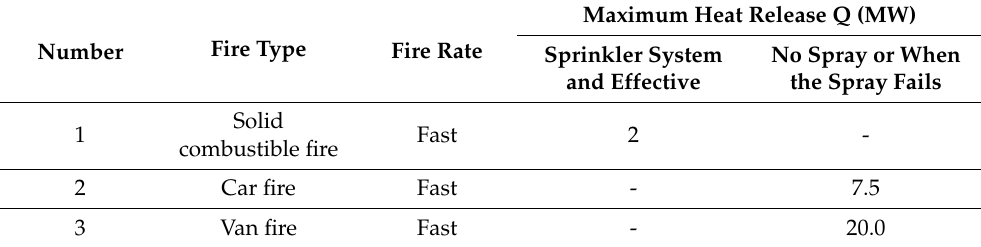
Table 5. Types and sizes of fires in common